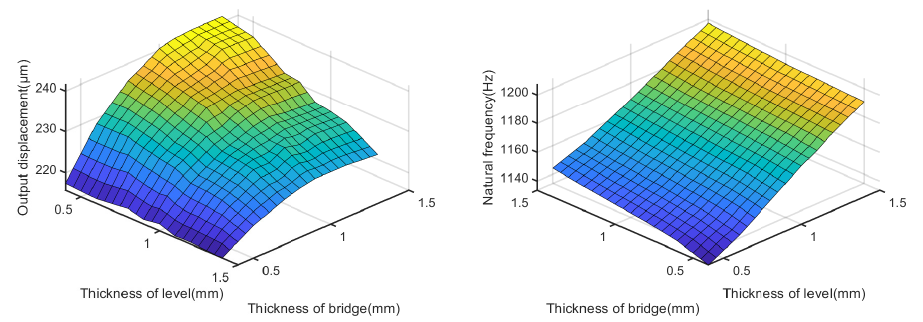
Figure 11. Effects of t b and t c on the output displacement and natural frequency.